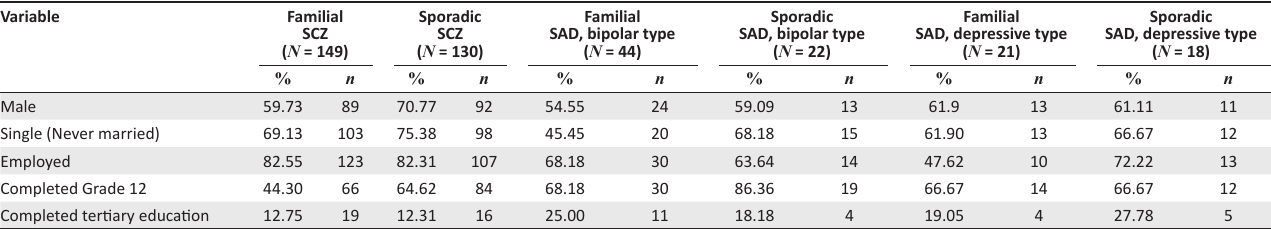
TABLE 1b: Demographic & clinical characteristics of 214 familial and 170 sporadic participants with a DSM diagnosis of schizophrenia or schizoaffective disorder. Variable